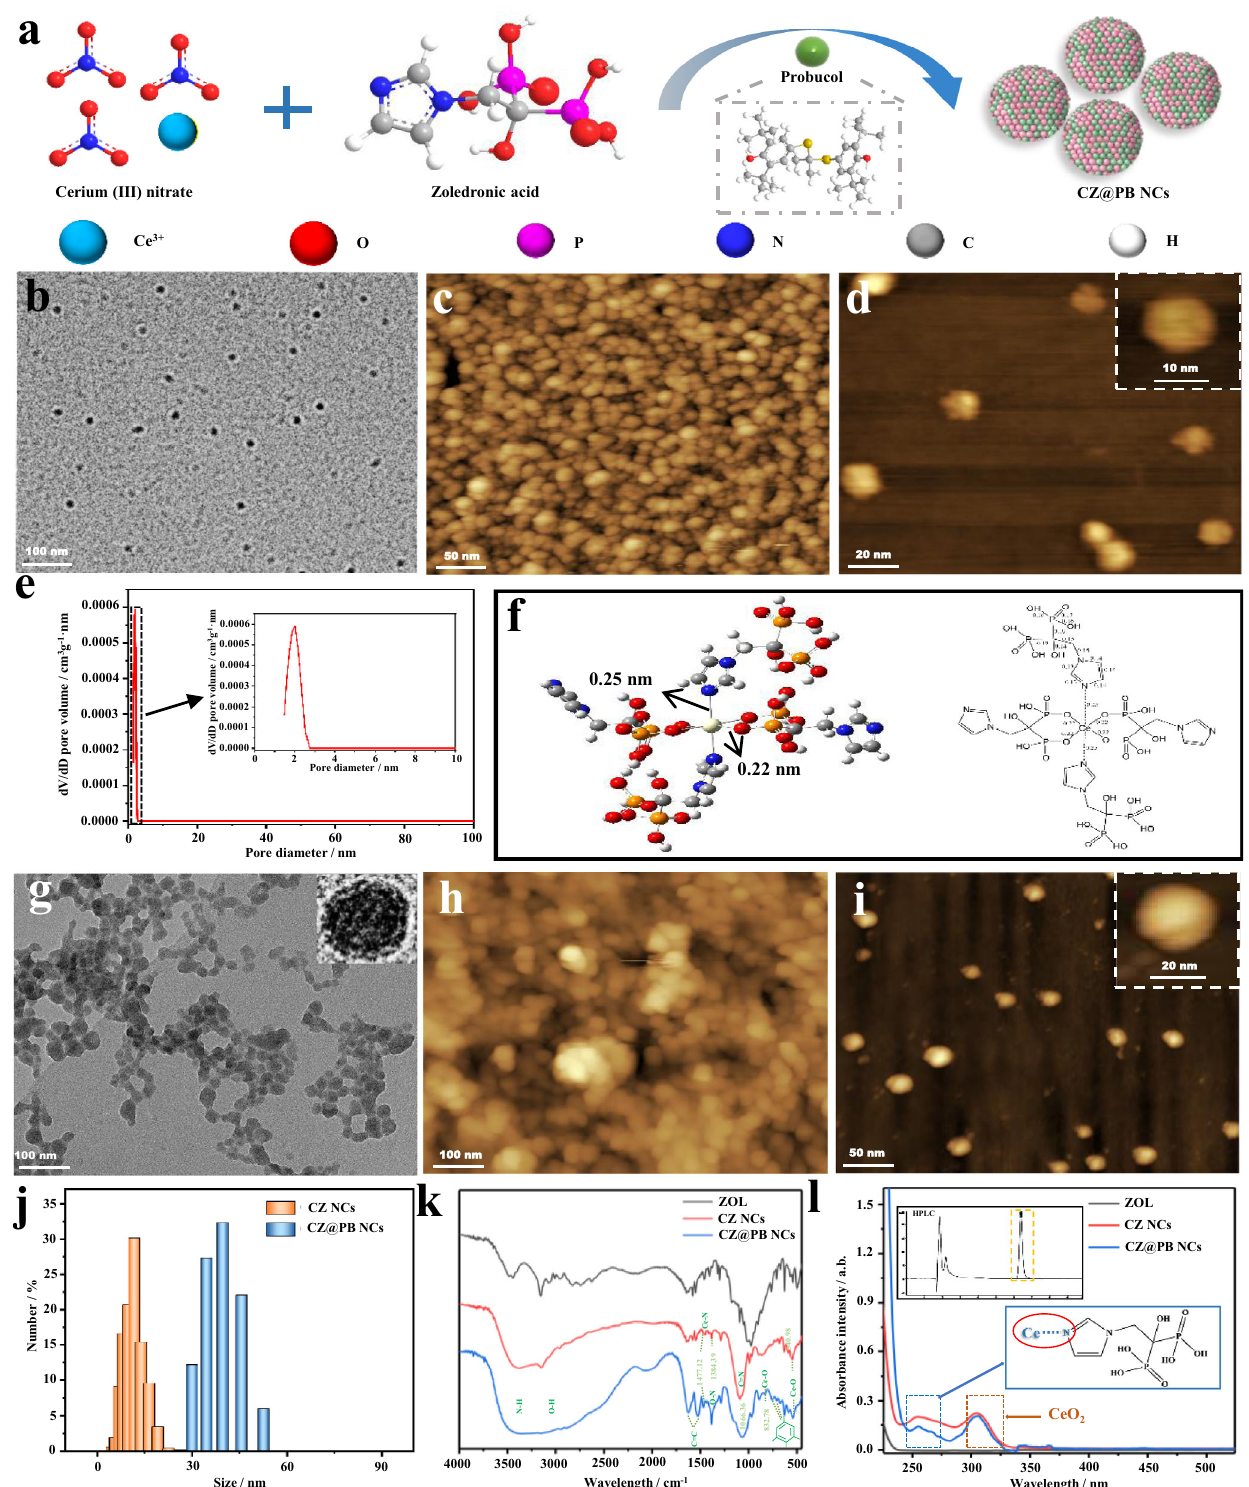
Fig. 2 | Preparation and characterization of CZ NCs and CZ@PB NCs. a Schematic illustrating the preparation of CZ@PB NCs. b TEM image of CZ NCs, and c , d AFM images of CZ NCs. e Pore size distribution of CZ NCs. f Molecular simulationofCZNCs. g TEMimageofCZ@PBNCs,and h , i AFMimagesofCZ@PB